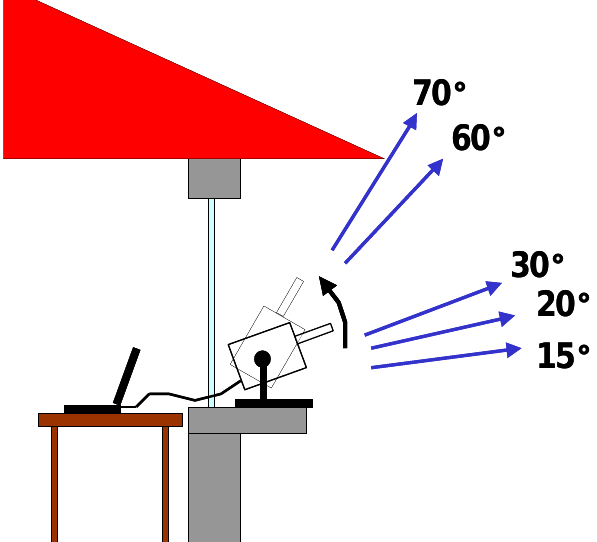
Fig. 1 Instrumental set-up at the Max Planck Institute for Chemistry, Mainz, Germany. A Mini-MAX-DOAS instrument was placed in front of a window. It was protected from rain by the roof of the building. But this roof also restricted the highest possible elevation angle to 70°. The lowest elevation angle (15°) was determined by the height of opposite buildings.